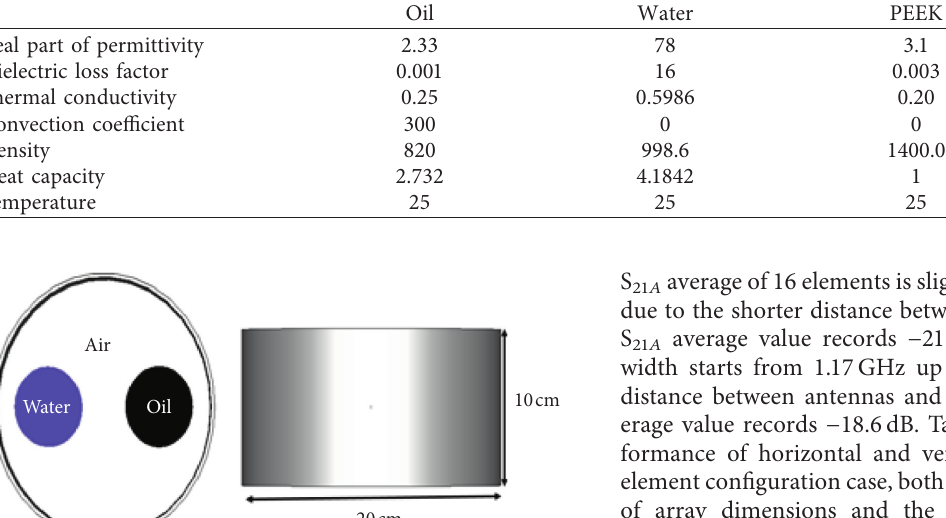
Table 1: Electromagnetic and thermal parameters at 2.45 GHz.